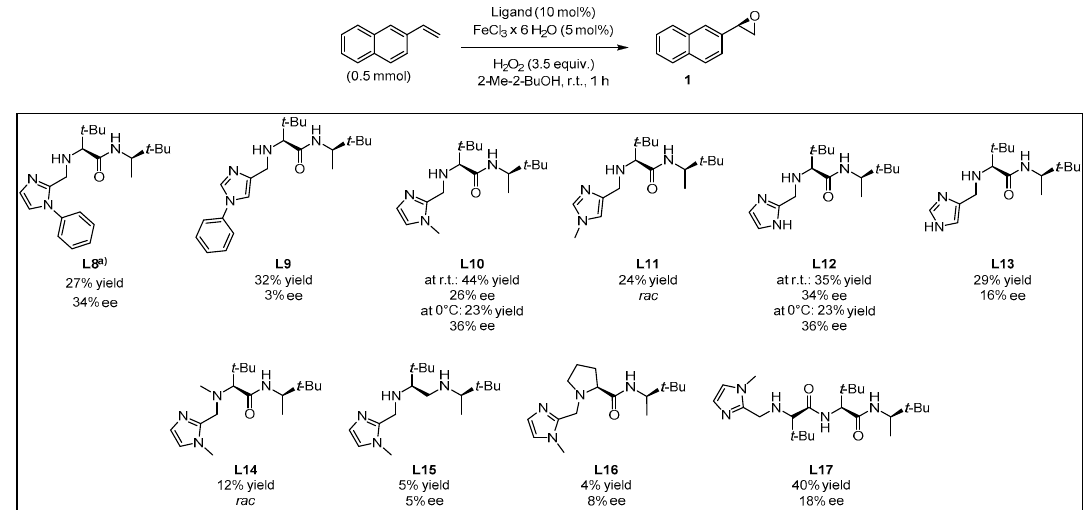
Figure 6. Screening of chiral peptide-like imidazole-based ligands. Yields determined via 1 H-NMR with pyrazine as internal standard; ee values determined via chiral HPLC measurement. (a) 0.33 mmol of 2-vinylnaphthalene was used.